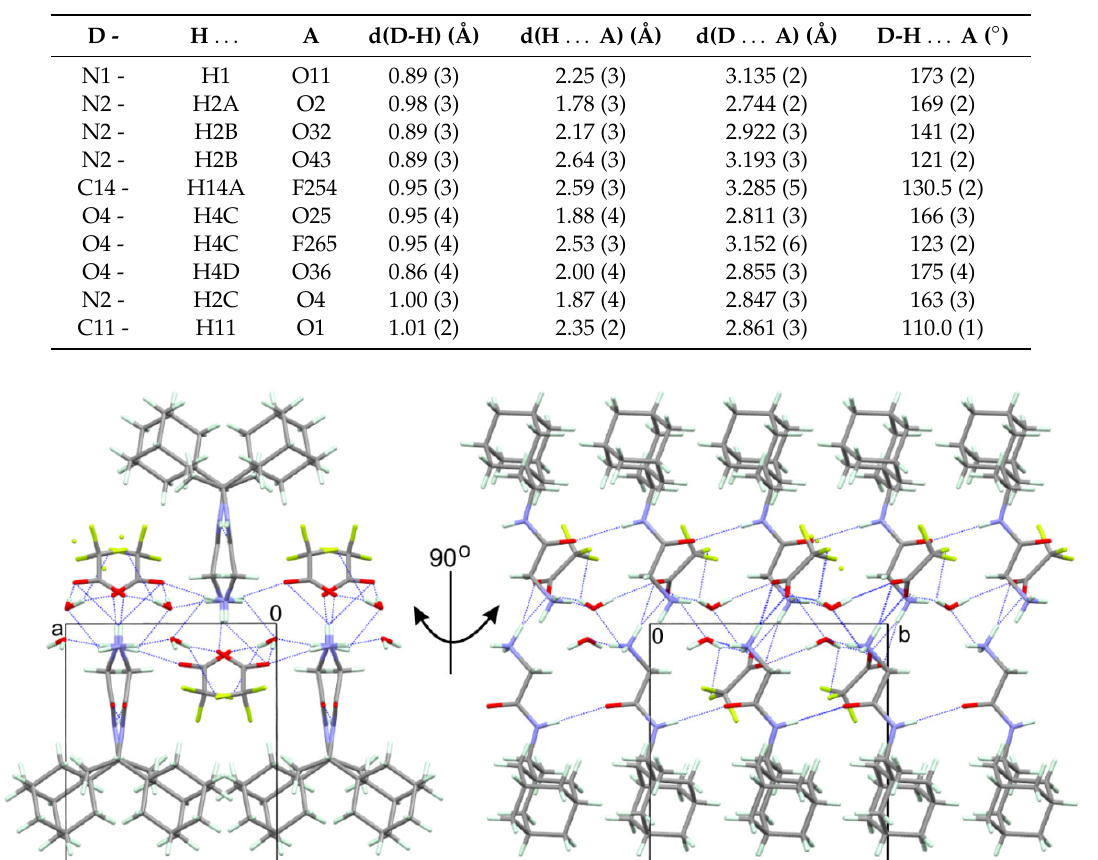
Figure 8. Three-dimensional packing and hydrogen bonding systems in the crystal structure of Glycyl-rimantadine ( 4b ): a view along the a and b axes.